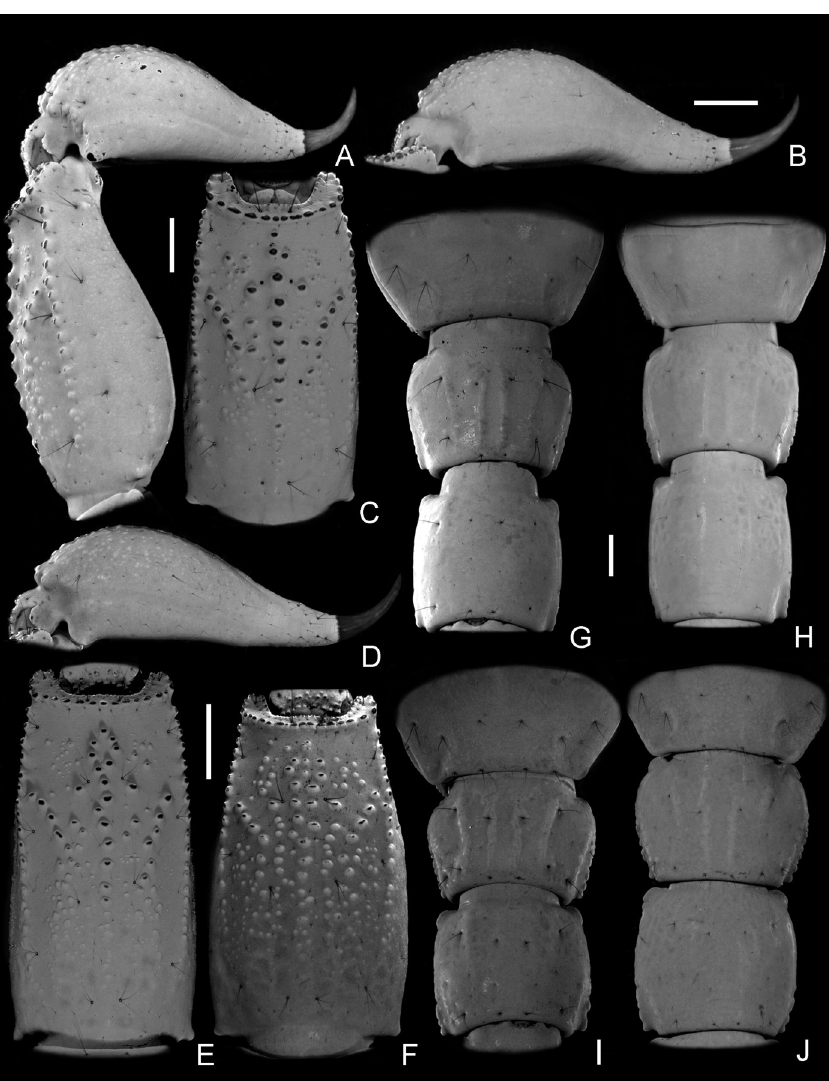
Fig 6. (A–J) (A–C, E, G, H). Bothriurus mistral n. sp. (A) Telson and metasomal segment V, female, lateral aspect; (B) Telson, male, lateral aspect; (C) Metasomal segment V, female, ventral aspect; (E) Metasomal segment V, male, ventral aspect; (G) Sternite VII and metasomal segments I and II, female, ventral aspect; (H) Sternite VII and metasomal segments I and II, male, ventral aspect; (D, F–J) Bothriurus coriaceus . (D) Telson, male, lateral aspect; (F) Metasomal segment V, male, ventral aspect; (I) Sternite VII and metasomal segments I and II, female, ventral aspect; (J) Sternite VII and metasomal segments I and II, male, ventral aspect. Scale bars: 1 mm. Colour : Base colour dark yellowish, with dark brown pigmentation pattern in pedipalps, carapace, tergites, metasoma and legs; the remaining yellowish without dark spots (Figs 2A and 4A–4D). Chelicerae with reticular pigmentation on the dorsal margin of manus; external margin of movable finger with a dark spot. Carapace, anterior margin of carapace densely pig- mented medially, connecting with two broad dark stripes from the anterior margin to the base of the postocular furrow, lateral margins with an anteromedian wide dark spot, and reticular pigment; posterolateral margins each with a dark spot, surrounded by reticular pigment; ocu- lar tubercle, and area around the lateral eyes dark brown, almost black. Tergites I–VI each